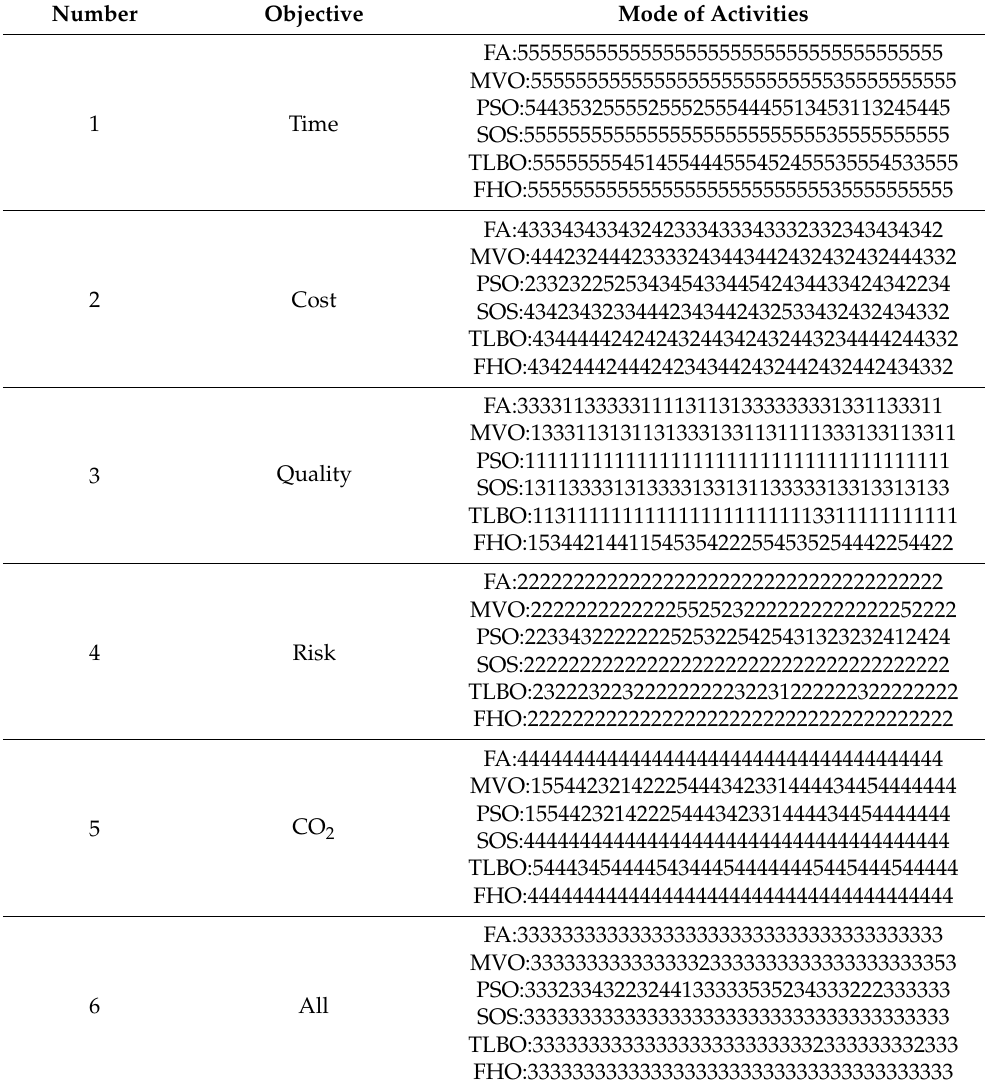
Table 4. Modes of different activities in optimization